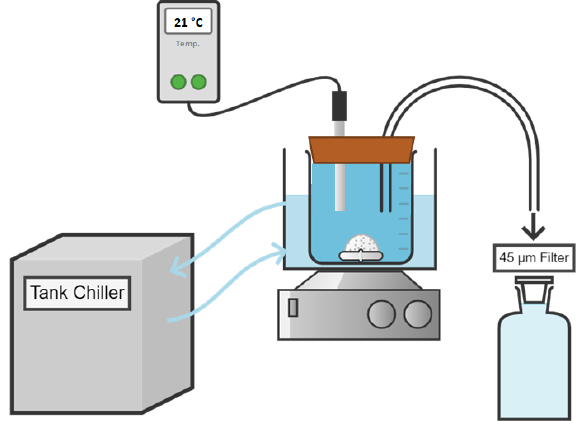
Figure A2. Conceptual diagram of the experimental setup used for the dissolution of alkaline minerals.